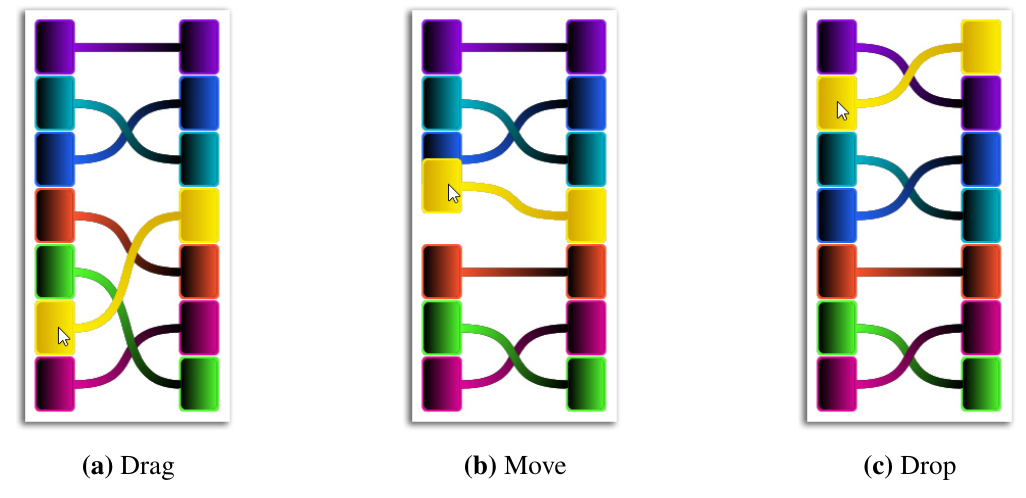
Figure 7. To enable an experience-based change of the features’ ranking, a drag and drop mechanism is introduced. The analyst is able to choose a feature ( a ), move it to a new position ( b ) and drop it ( c ). As a result, the system incorporates the change and adapts the ranking algorithm and the visualizations to his or her